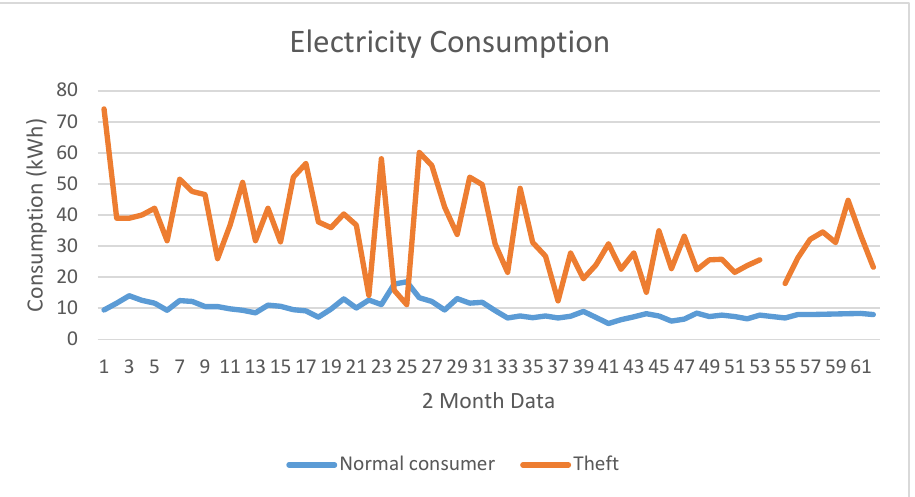
Figure 1. Two months electricity consumption data of a normal